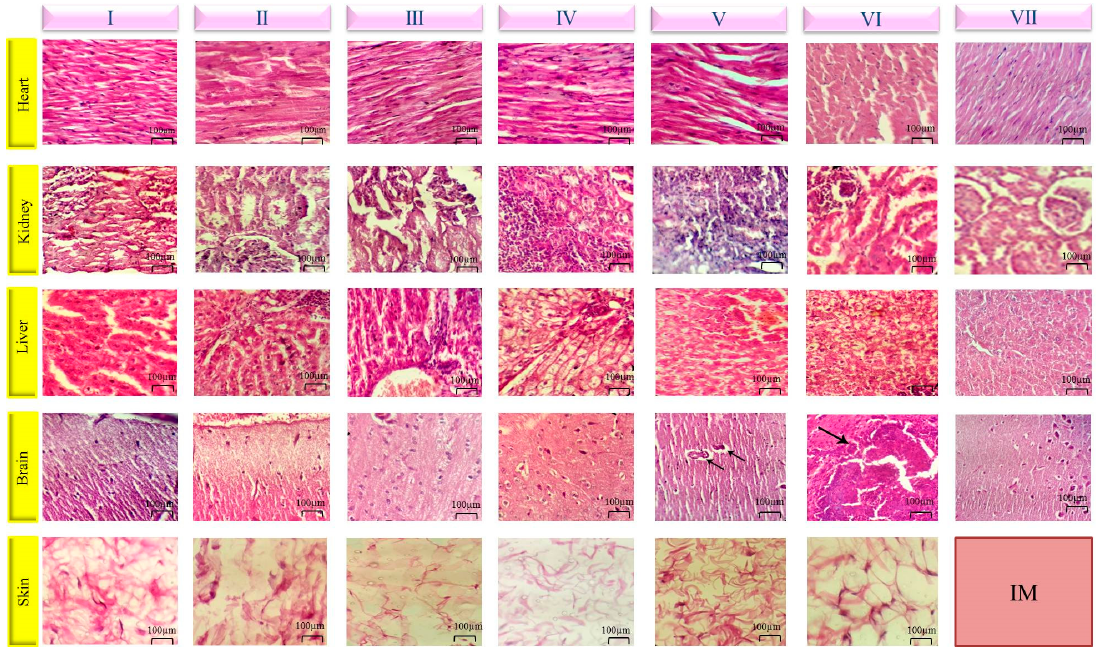
Figure 7. Untreated control group ( I ), ISFI (SC) ( II ), ISFG (SC) ( III ), risperidone solution in NMP (SC) ( IV ), ISFI with risperidone (SC) ( V ), ISFG with risperidone (SC) ( VI ) and Risperdal CONSTA ® (IM) ( VII ). The pathological sign is indicated by arrows. H & E staining images × 400.